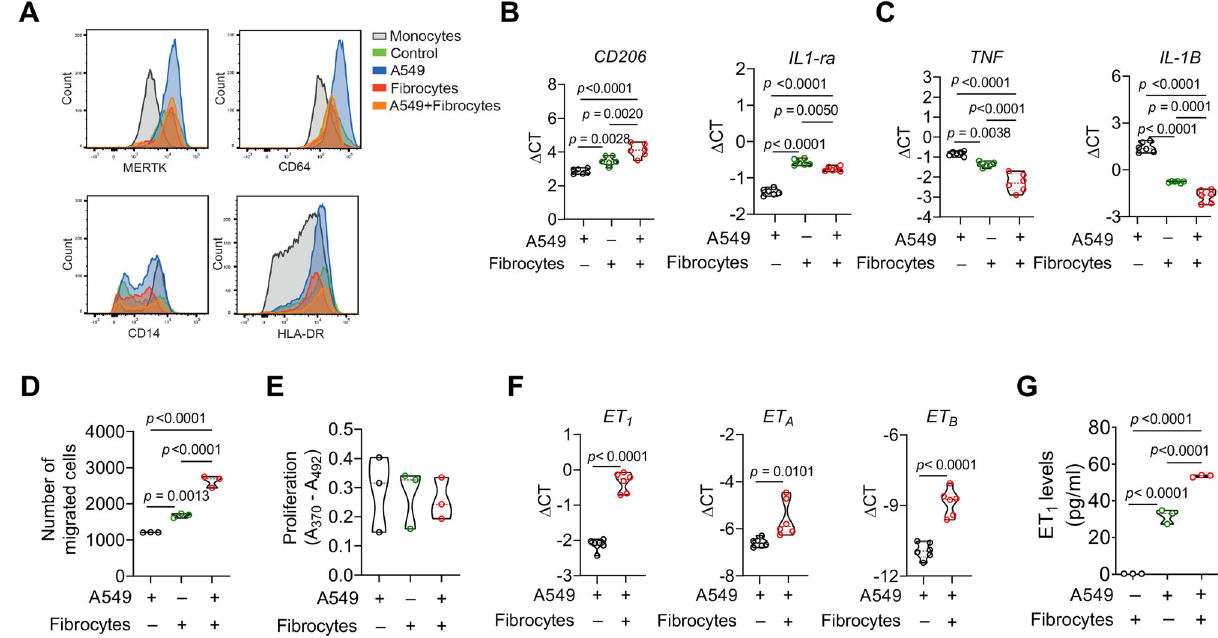
Fig. 7 | Cross-talk between fi brocytes and cancer cells promotes macrophage activation,migrationandendothelialsystemincancercells.A FACSanalysisof MERTK, CD64, CD14 and HLA-DR cell surface expression on monocytes or monocyte-derived macrophages. The control (green curve) corresponds to mac- rophages differentiated with human serum. B , C Expression of macrophage mar- kers CD206,IL1-ra,TNF ,and IL-1B inmacrophagesincubatedwithCMfromA549or A549+ fi brocytesco-cultures, n =6. D Migration( n =3independentexperiments,3 technical replicates) and ( E ) proliferation ( n =3 independent experiments, 8